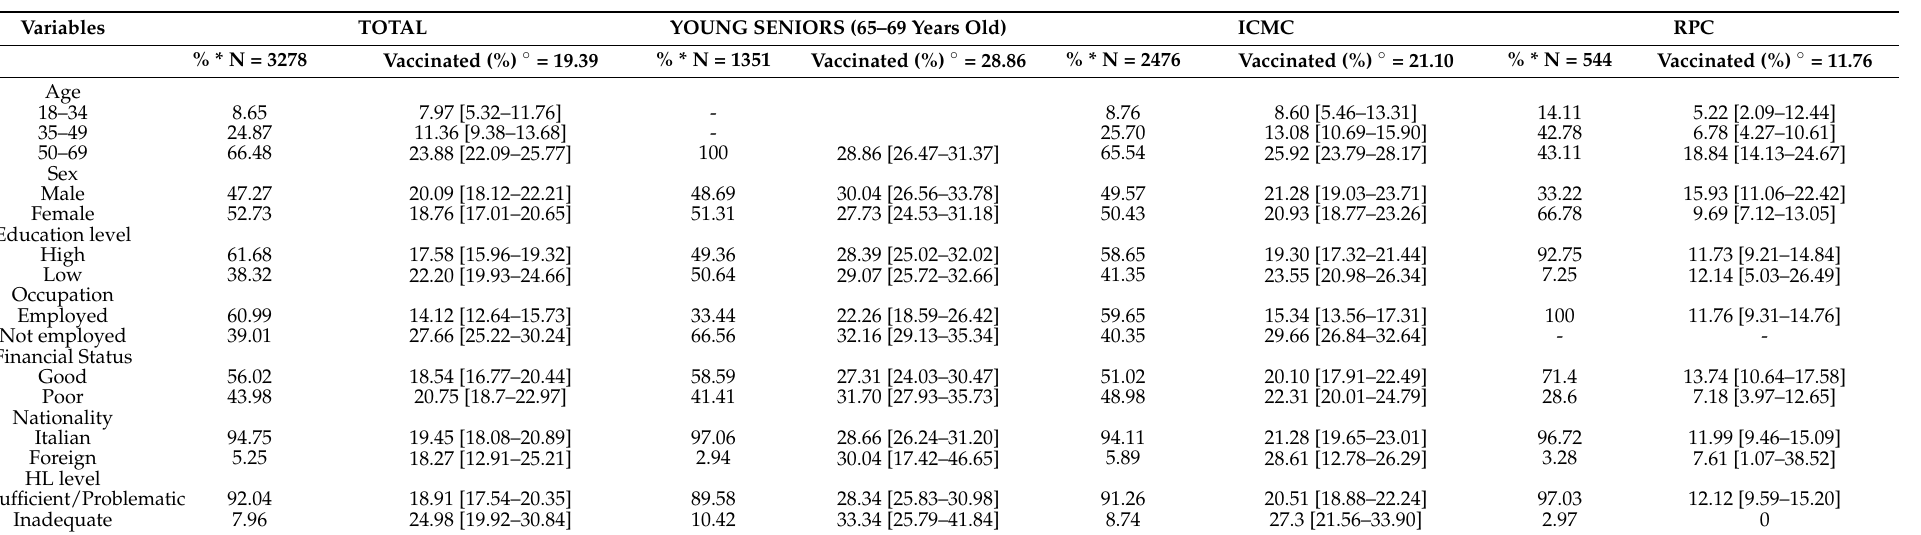
Table 1. Descriptive analysis of collected variables -total sample, young seniors, individuals with chronic medical conditions (ICMC) and at-risk professional categories (RPC)- in the whole sample and by influenza vaccination